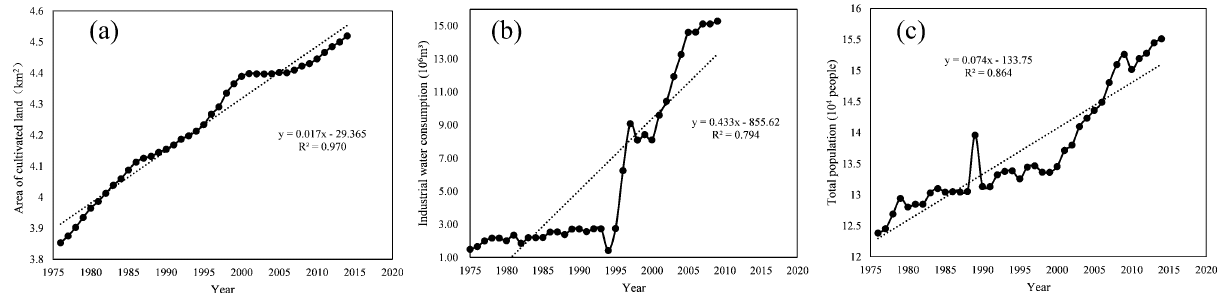
Figure 11. Perennial ( a ) cultivated land area ( b ) industrial water consumption ( c ) total population change curve in Daihai